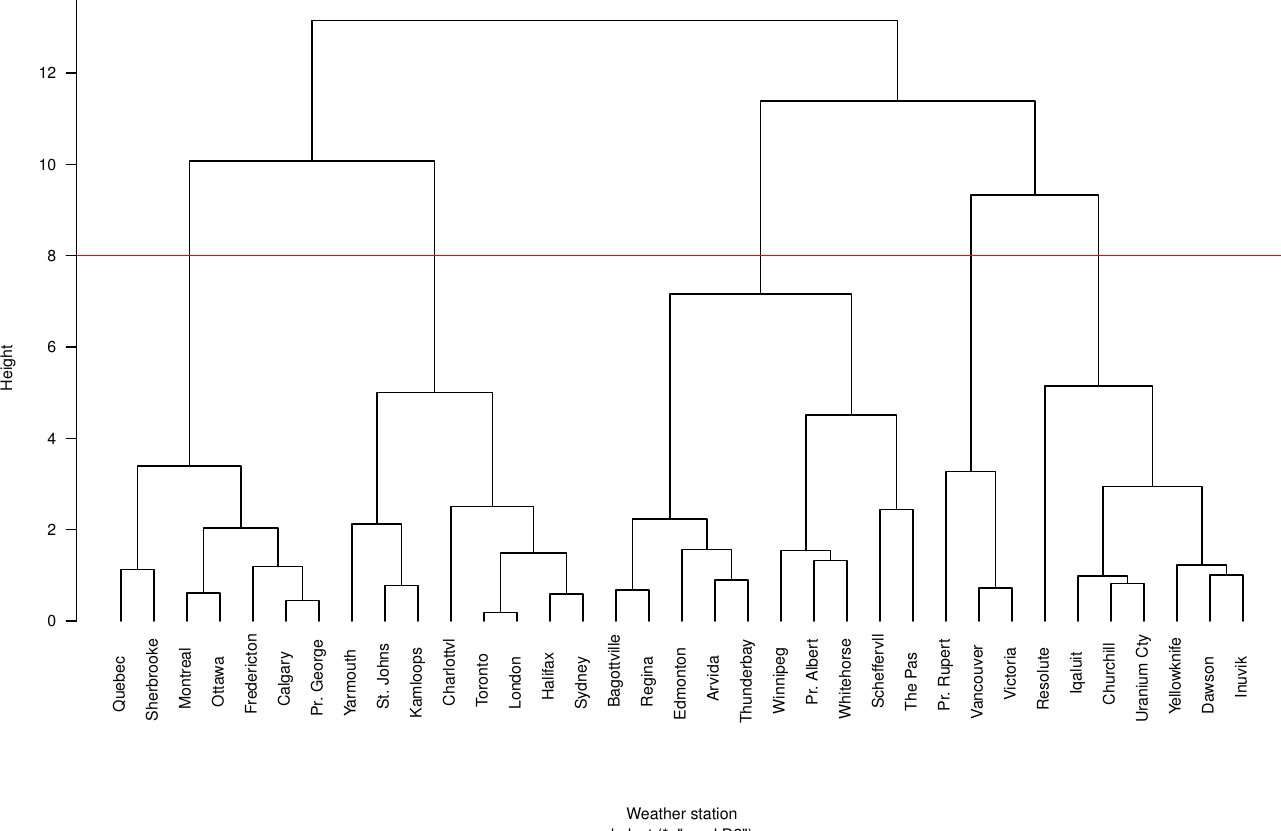
Figure A1. Dendrogram of Canadian weather stations. The clusters are, from left to right, C2 (from Quebec to Pr. George), C1 (from Yarmouth to Sydney), C3 (from Bagottville to The Pas), C5 (from Pr. Rupert to Victoria), and C4 (from Resolute to